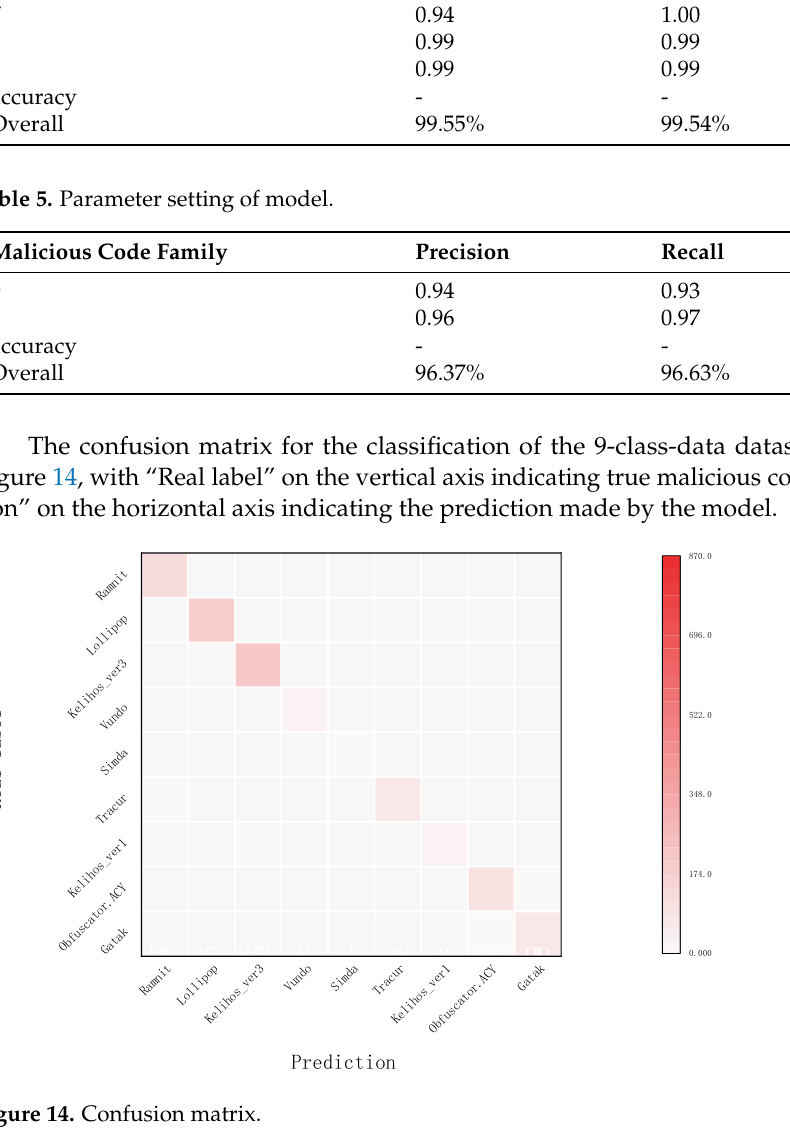
Table 4. Parameter setting of model.